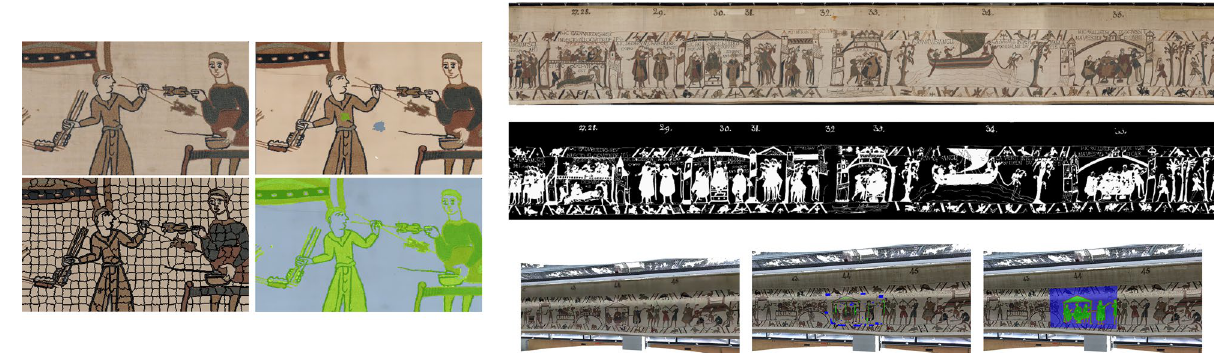
Figure 3. Semi-supervised segmentation of the Bayeux Tapestry. Left: superpixel-based segmentation of a single scene (initial image, image with seeds, image partition with supervertices using a regular grid of seeds, and segmentation result). Right, first and second rows: segmentation of the foreground on 2D images (initial image and segmentation result). Right, third row: 3D point cloud segmentation (from left to right: initial image, image with initial labels, segmentation result).